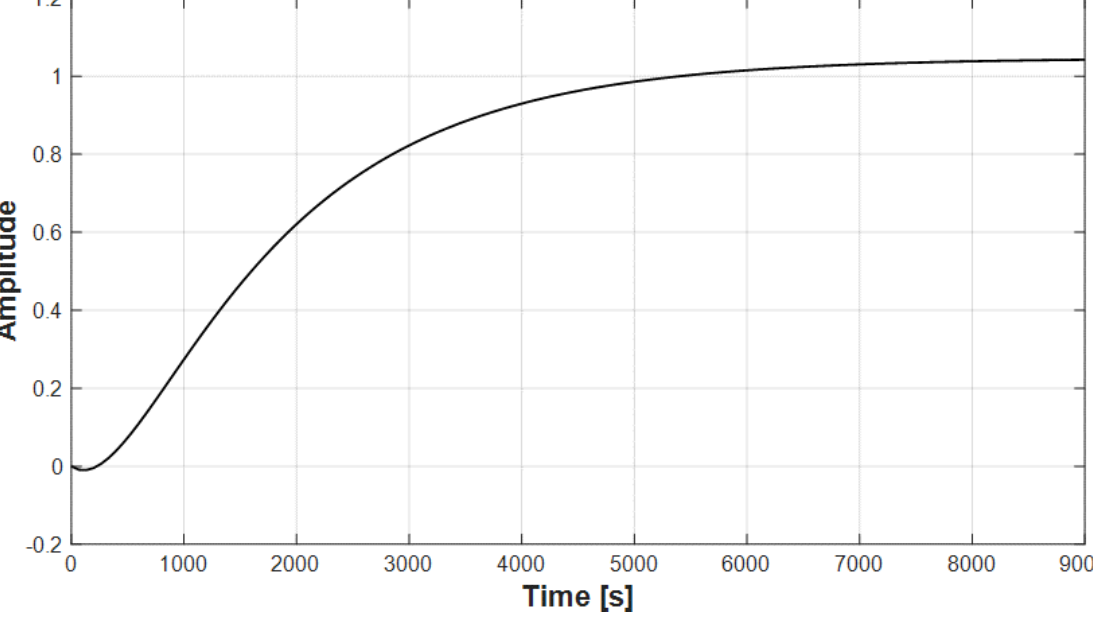
Figure 10. Step response of the disturbance path.